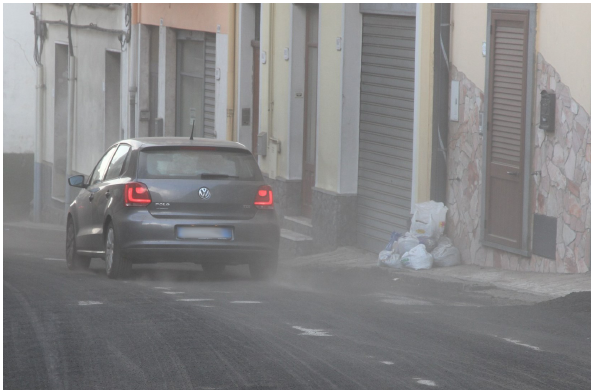
Figure 10. The remobilization of ash in the air after the 16 March 2013 tephra fallout at Zafferana